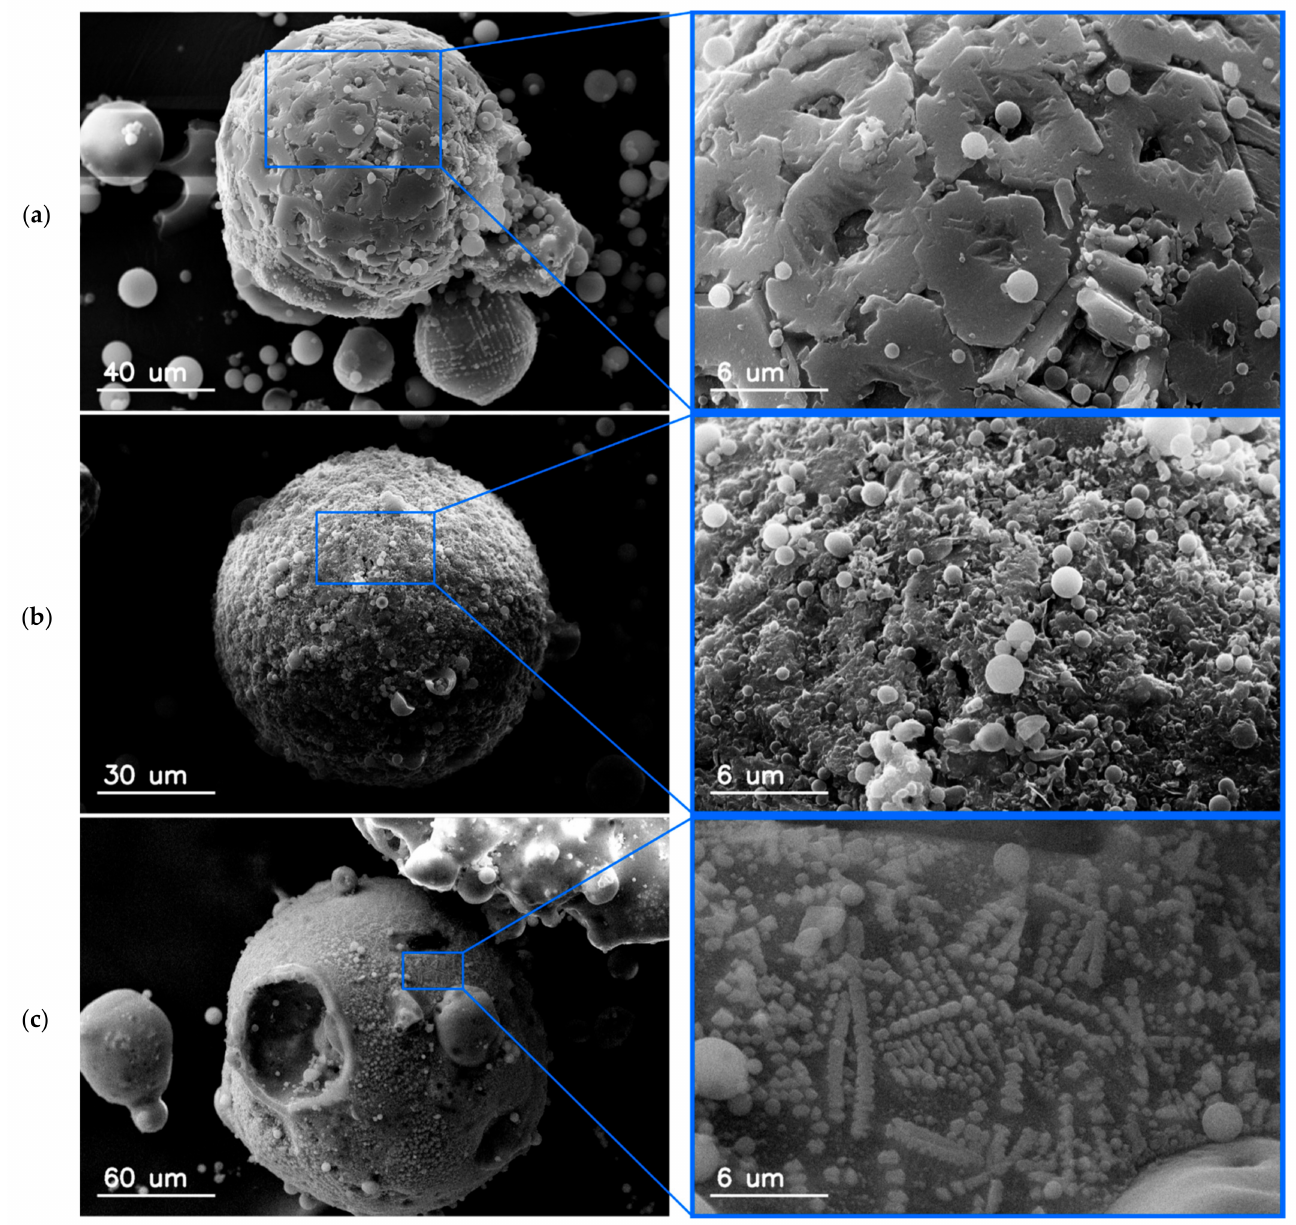
Figure 4. SEM micrographs of surface morphology of magnetic particles: ( a ) 45.95; ( b ) 42.38; ( c ) 49.6 (in wt.%).